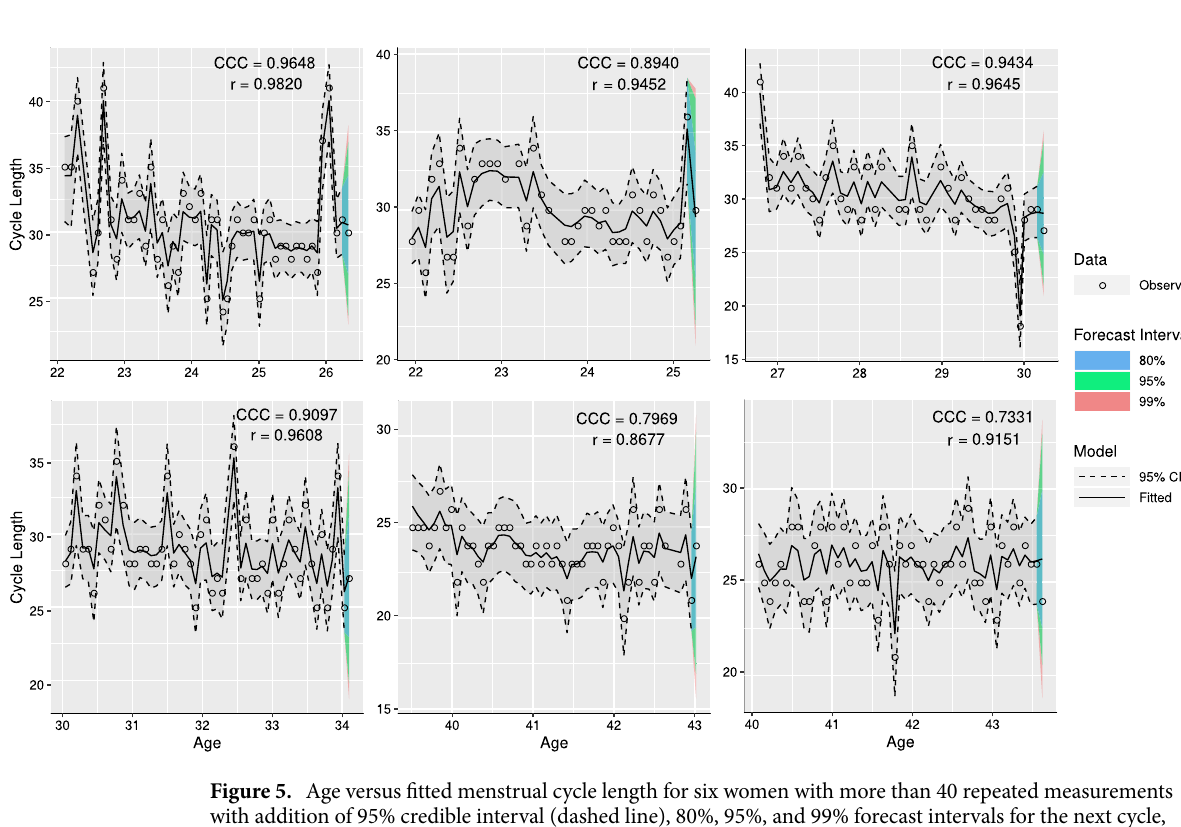
Figure 5. Age versus fitted menstrual cycle length for six women with more than 40 repeated measurements with addition of 95% credible interval (dashed line), 80%, 95%, and 99% forecast intervals for the next cycle, and observed menstrual cycle length as points. The estimated concordance correlation coefficient (CCC), and Pearson correlation coefficient (r) between fitted and observed values are described for each woman. Accuracy ( C b ) can be obtained using C b = CCC / r